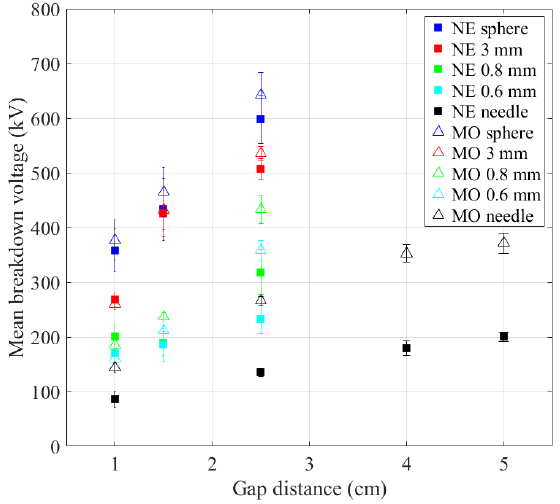
Figure 4. Mean breakdown voltages versus gap distance at negative polarity for mineral oil and natural ester liquid.